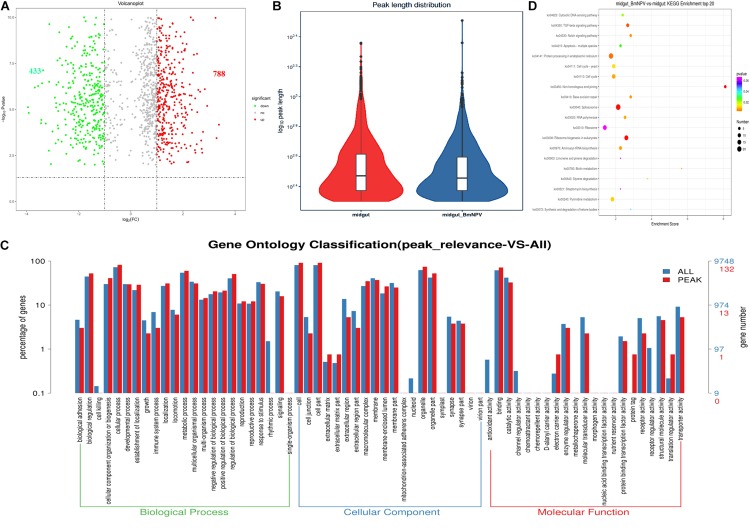
Analysis of sites with differential m6A modification following BmNPV infection. (A) Volcano plot of sites with differential m6A modification. (B) Distribution of sites with differential m6A modification. (C) GO analysis of transcripts with differential m6A modification. (D) Top 20 KEGG enrichment of transcripts with differential m6A modification.